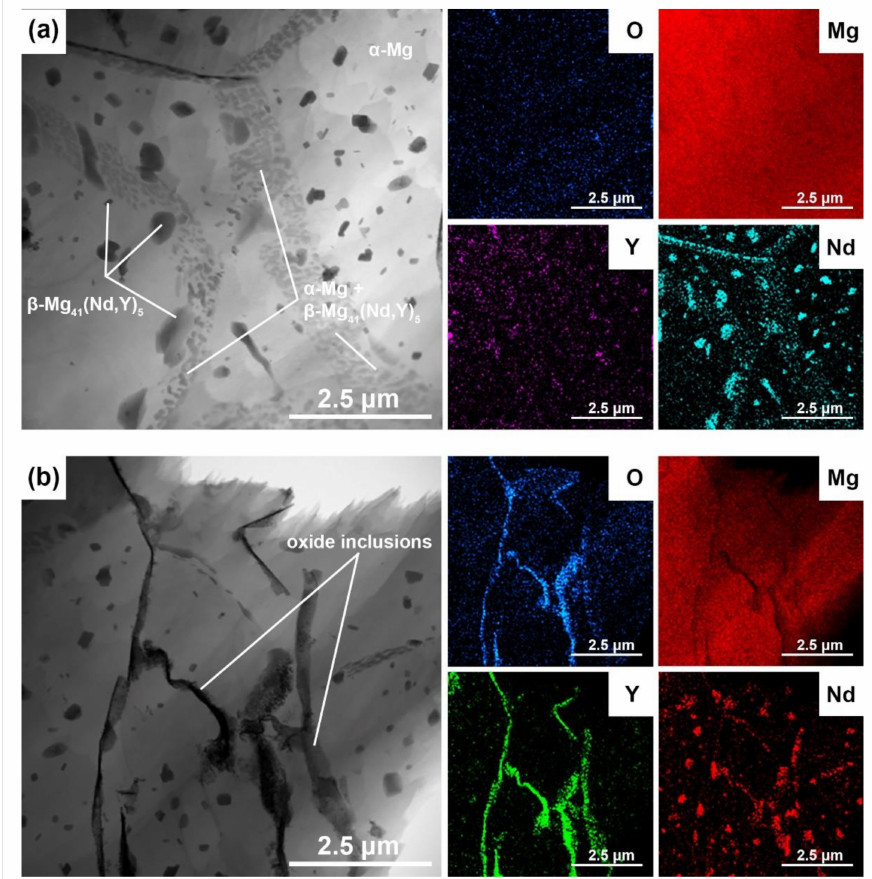
Figure 8. TEM micrograph and elements distribution maps of the 3D-printed WE43: ( a ) detail in the vicinity of dendrite boundaries, ( b ) detail of oxide